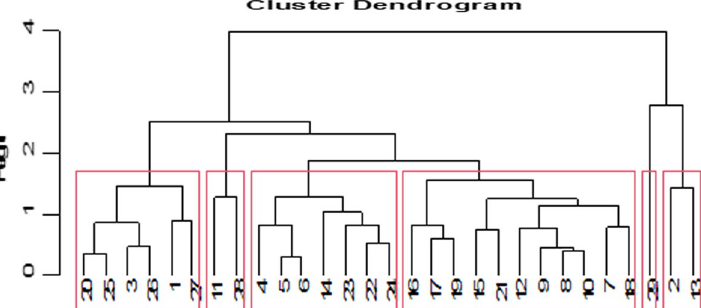
Fig. 2 Cluster dendrogram with spatiotemporal correlation in Stage 1. Note The numbers 1, 3, 12, 14, 16, and 23, 26 denote stock indices in developed markets; the remaining numbers denote indices in developing markets, according to Tables 2 and